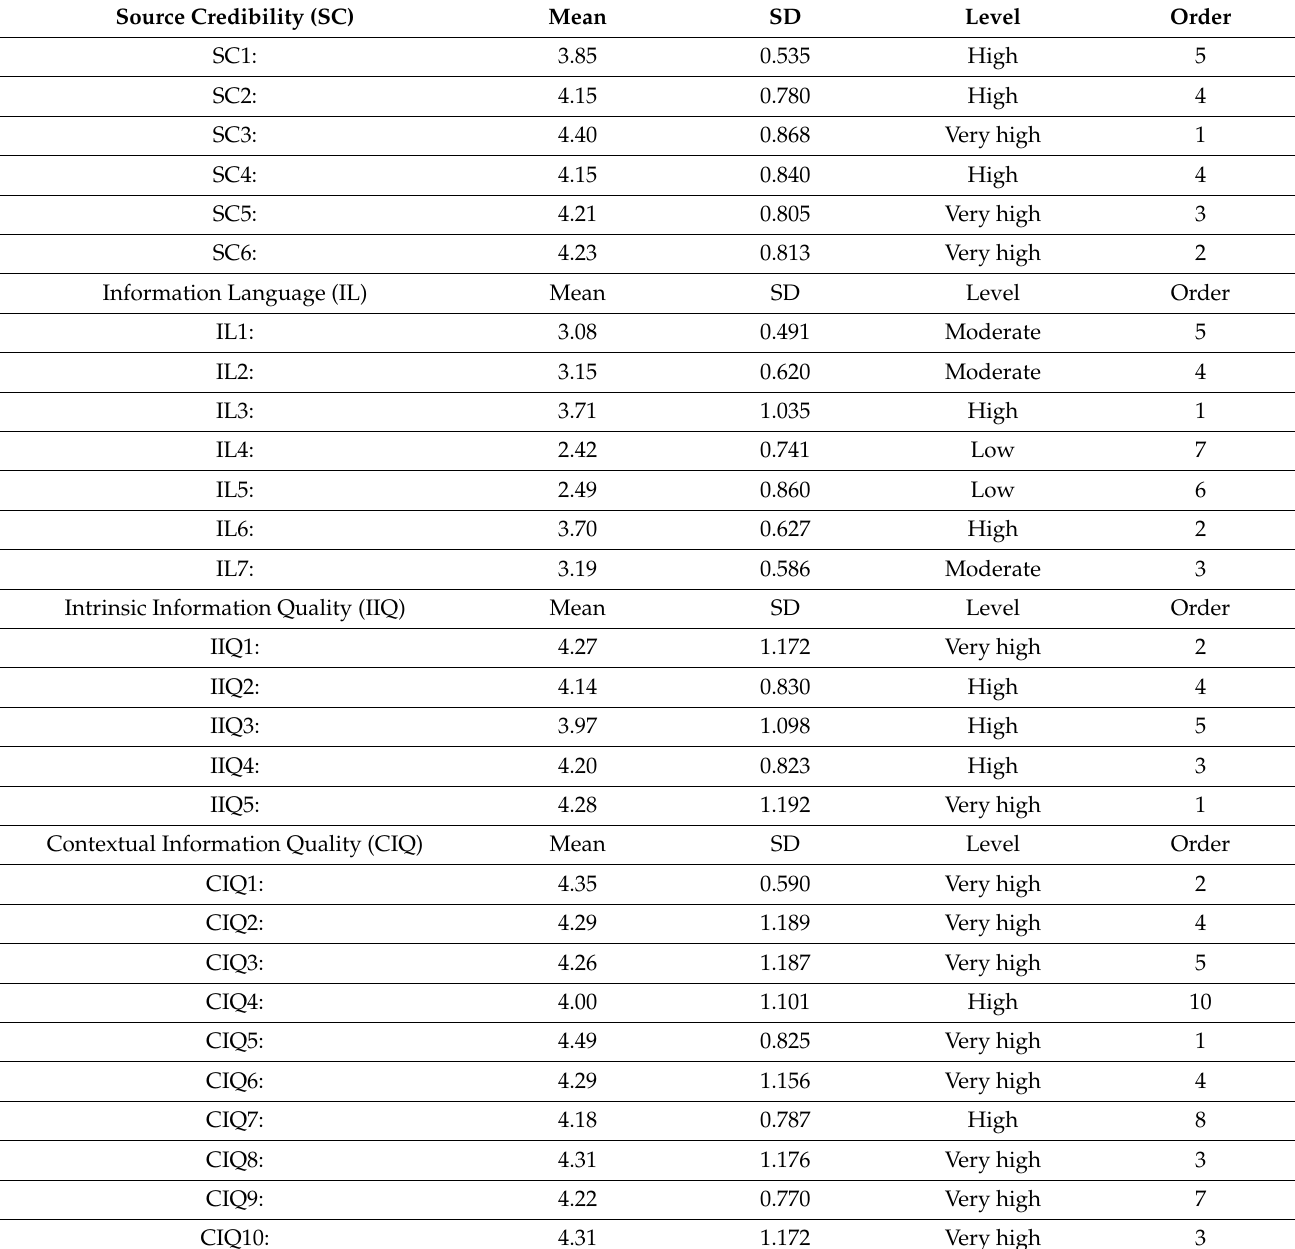
Table 4. Mean and standard deviation of the study’s